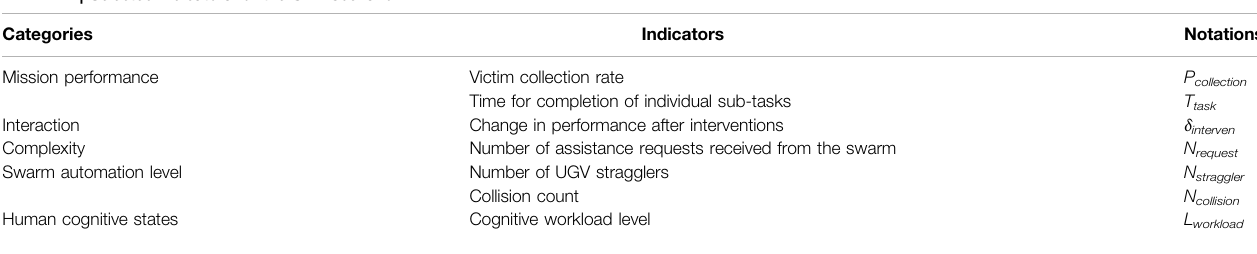
TABLE 2 | Selected indicators for the SAR